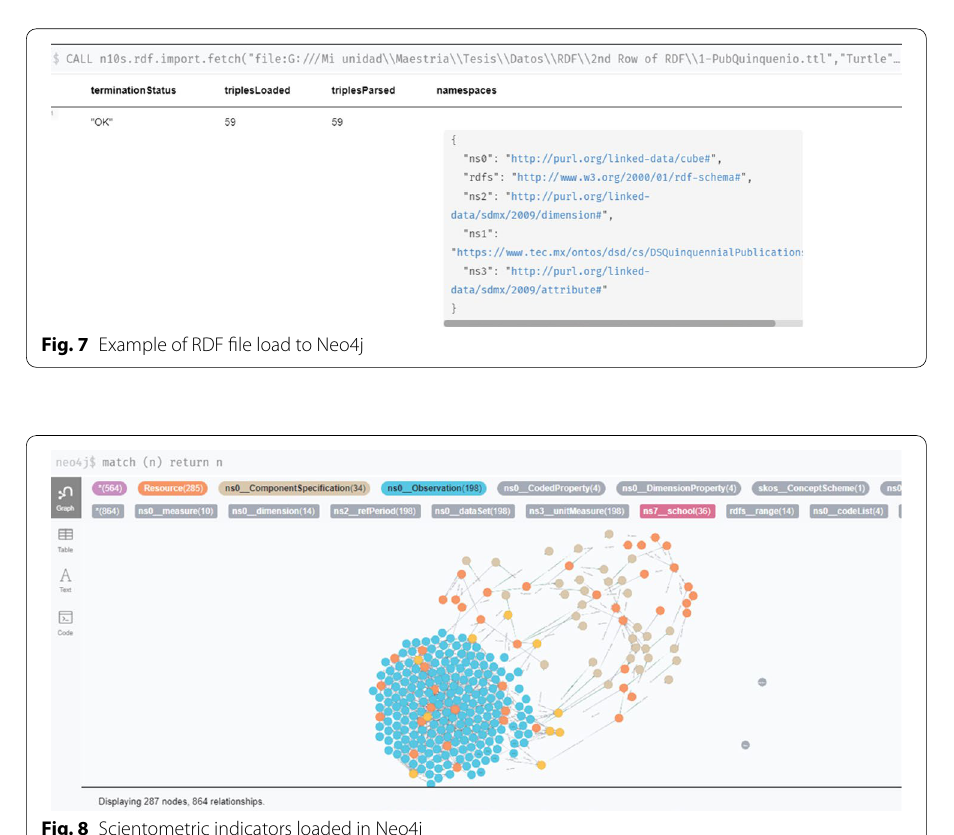
Fig. 8 Scientometric indicators loaded in